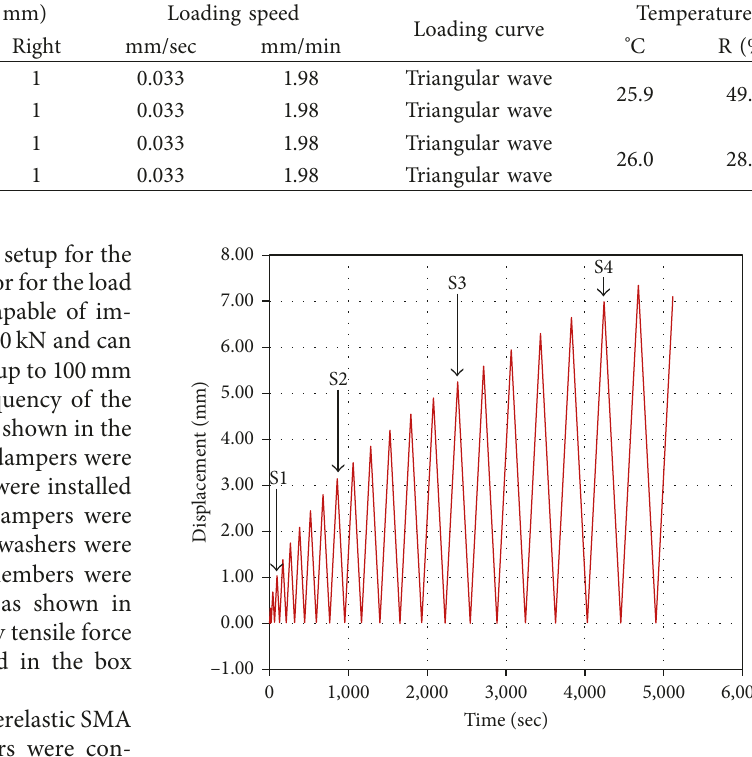
Figure 8: Loading